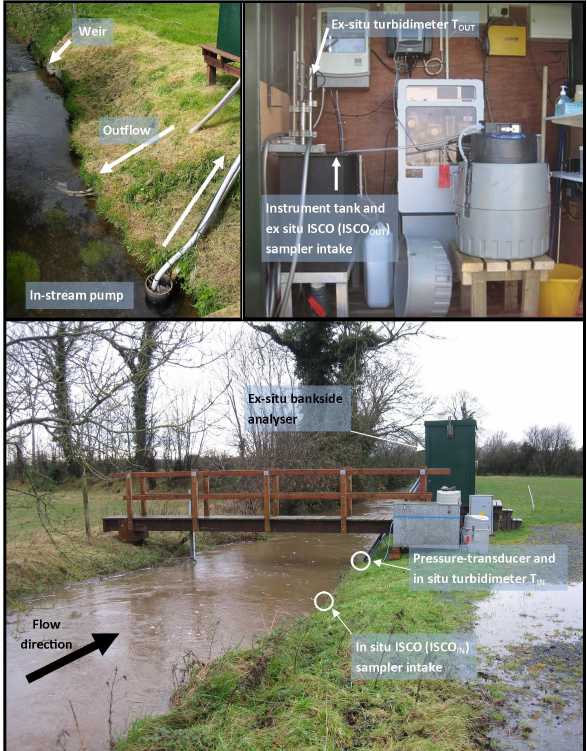
Figure 2. Picture of in situ and ex situ suspended sediment and discharge instrumentation at Grassland